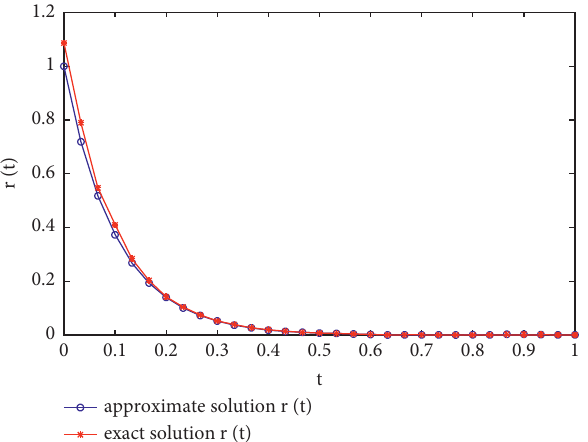
Figure 4: Reconstructions of r ( t ) of Example